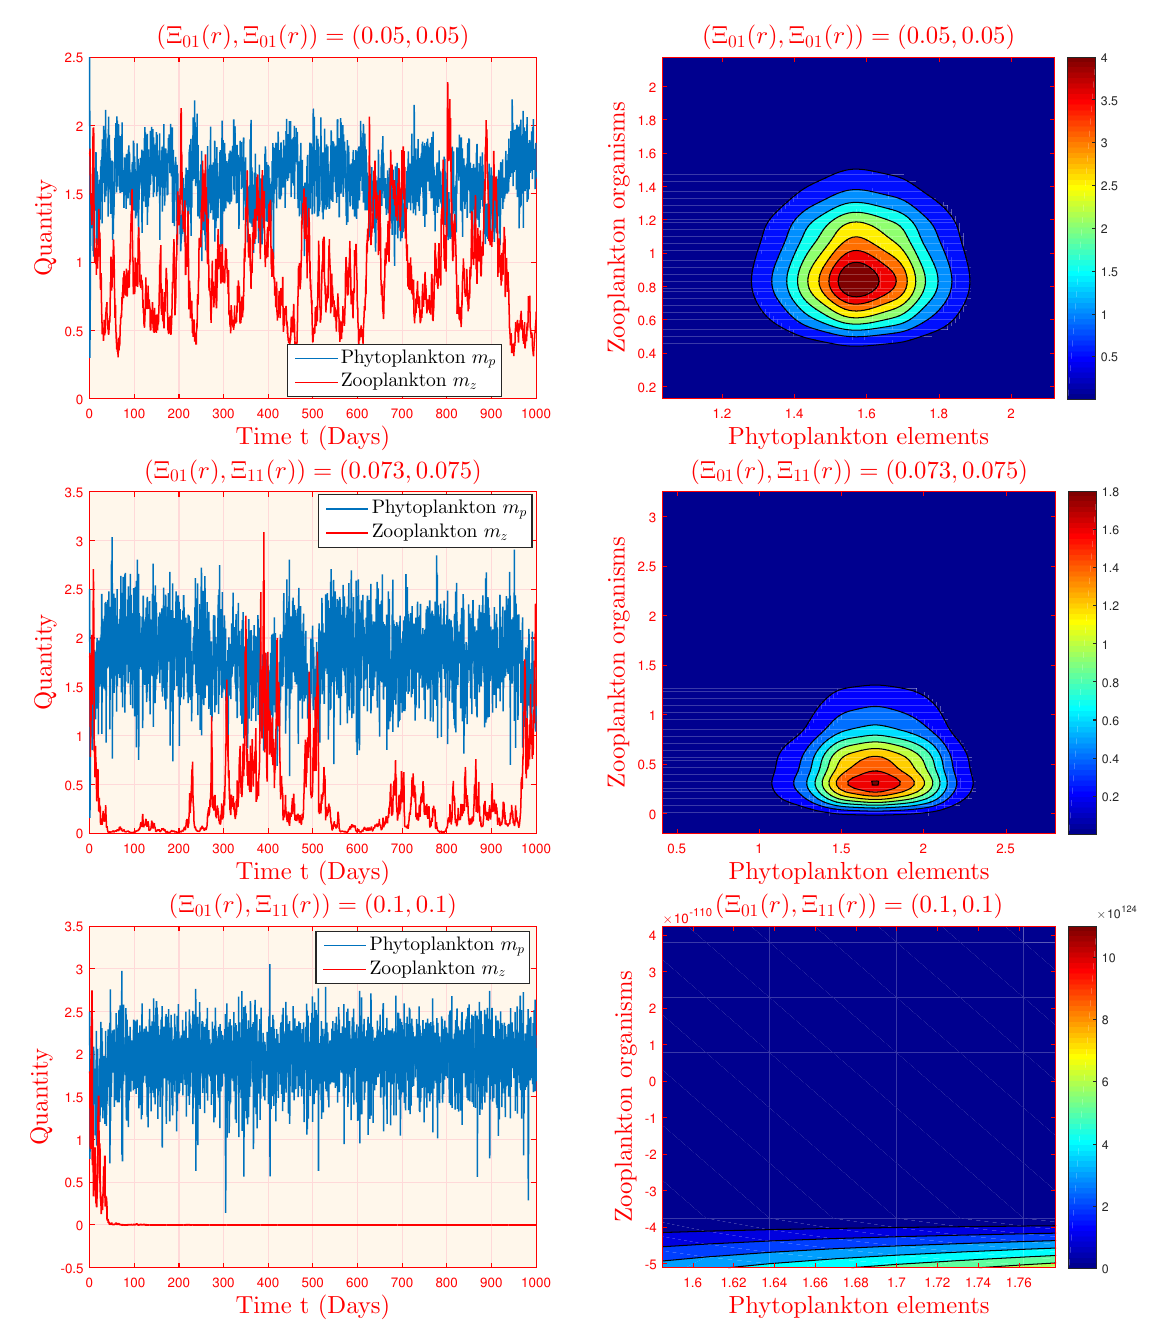
Figure 7. Illustration of the dynamic transition induced by quadratic jumps. From 0.05 to 0.1, we pass from the case of stationarity to the case extinction scenario. The fixed deterministic coeffi- cients are chosen from Table 1 (Test 1). For random amplitudes, we select Υ 00 = 0.17, Υ 01 = 0.1, Υ = 0.01, Υ = 0.13, Υ = 0.112, Υ = 0.001, Ξ ( r ) = 0.1, Ξ ( r ) = 02 00 10 11 12 10